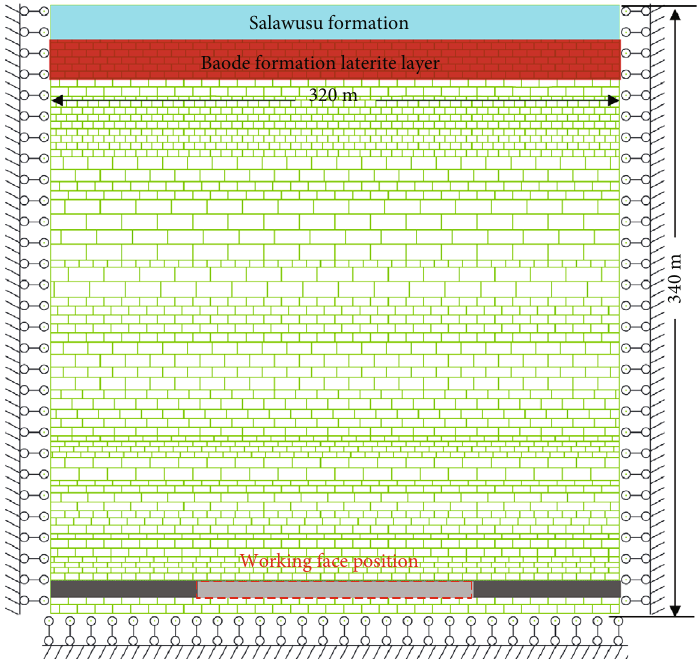
Figure 5: Geometric model of numerical